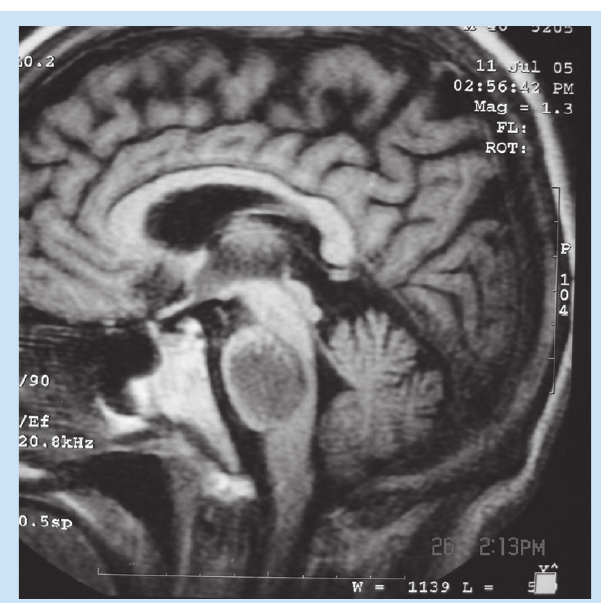
Fig. 2. Sagittal T1WI showing hypointense lesion in the central